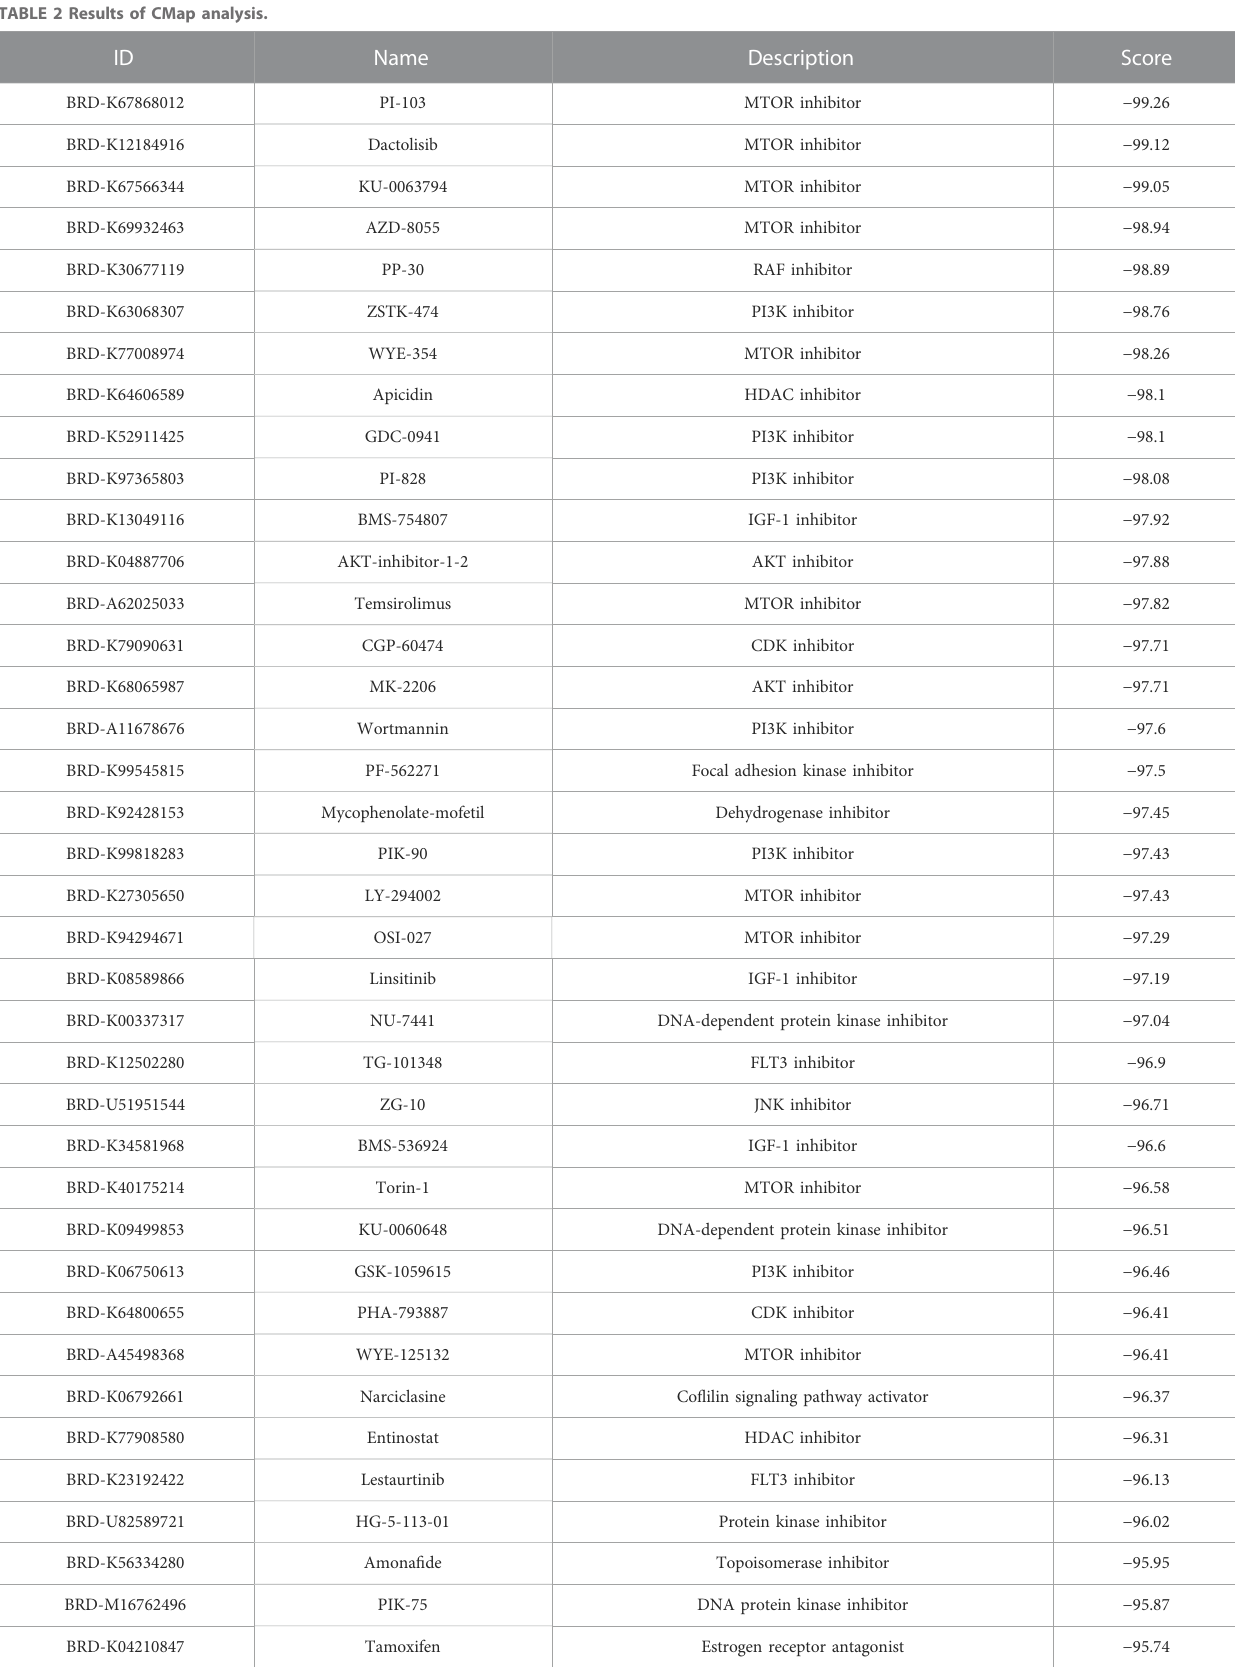
TABLE 2 Results of CMap